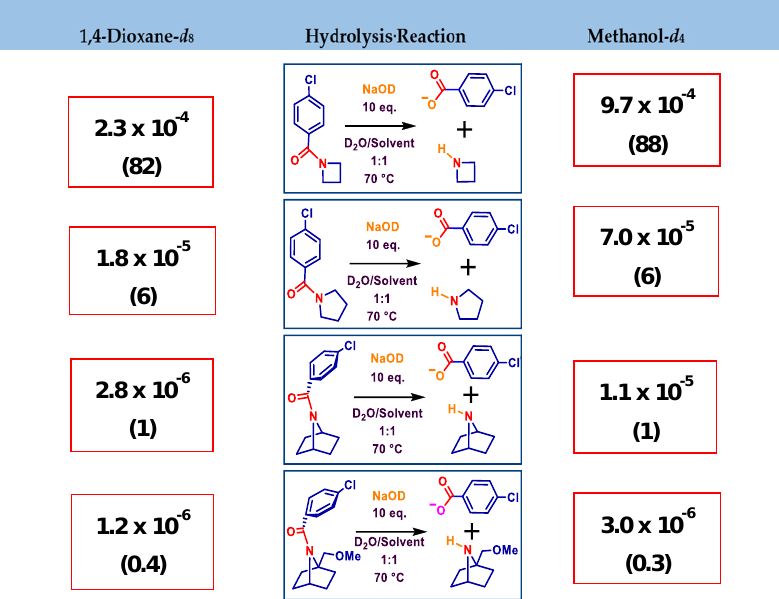
Figure 9. Base-catalyzed hydrolysis rates of 2c, 3c, 4c and 5c in two solvent systems (1,4-dioxane and methanol). Values of − k obs (s − 1 ) are shown. Relative reaction rates are shown in parentheses (referenced to 4c